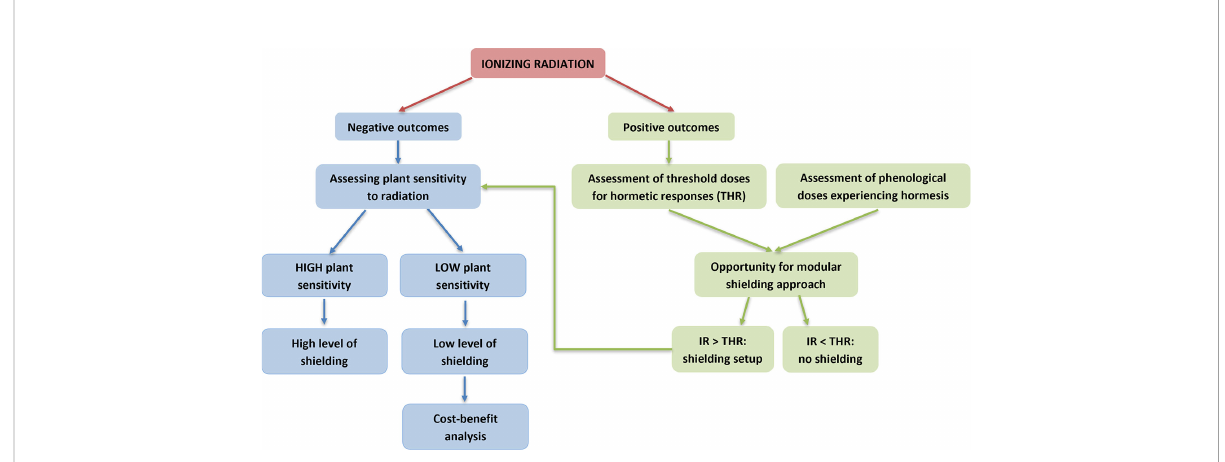
FIGURE 5 A fl ow chart for de fi nition of shielding requirements for plant growth in Space in relation to sensitivity to ionizing